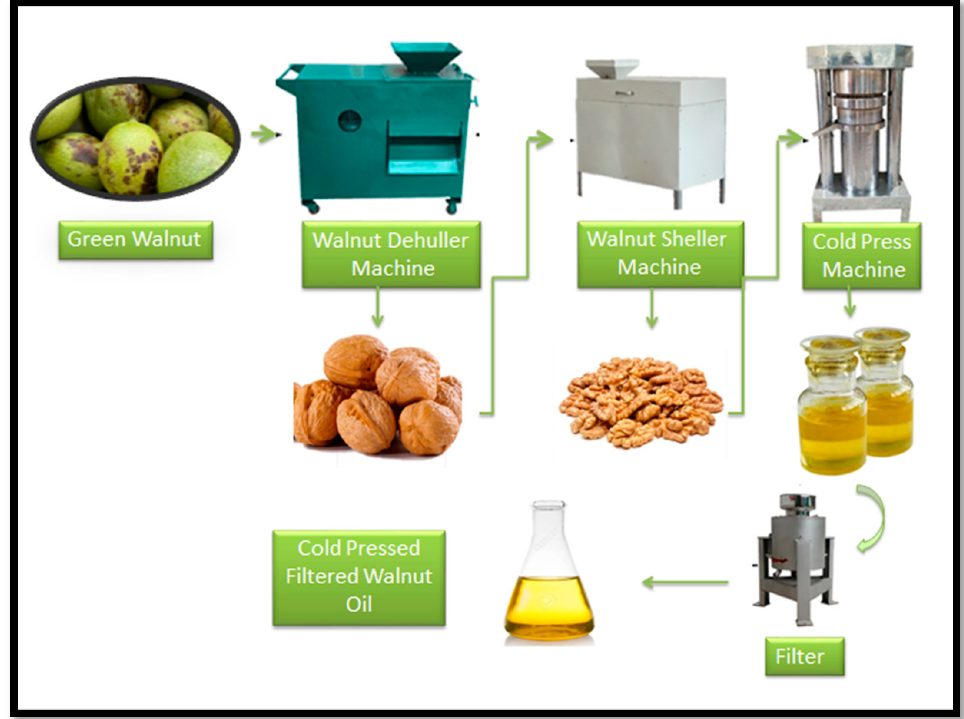
Figure 2. Graphical representation of cold oil extraction process.